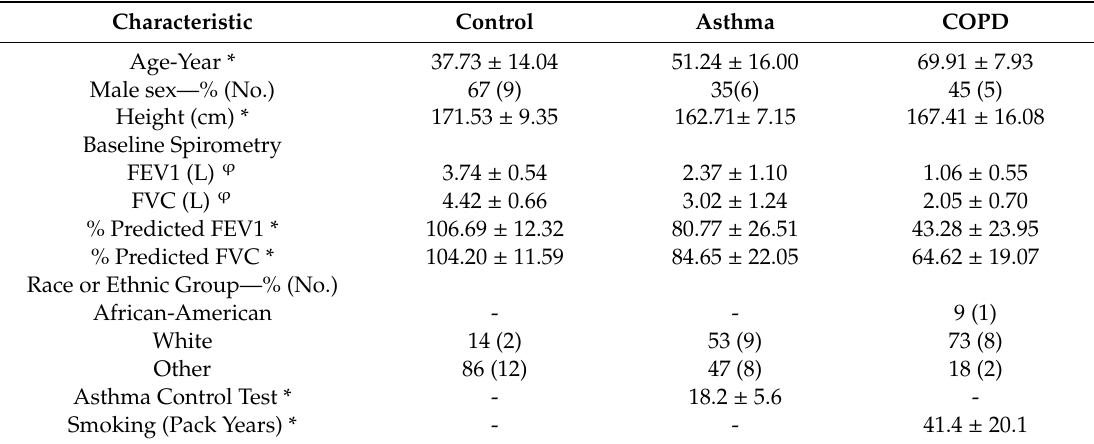
Table 1. Demographics of clinical cohort and testing